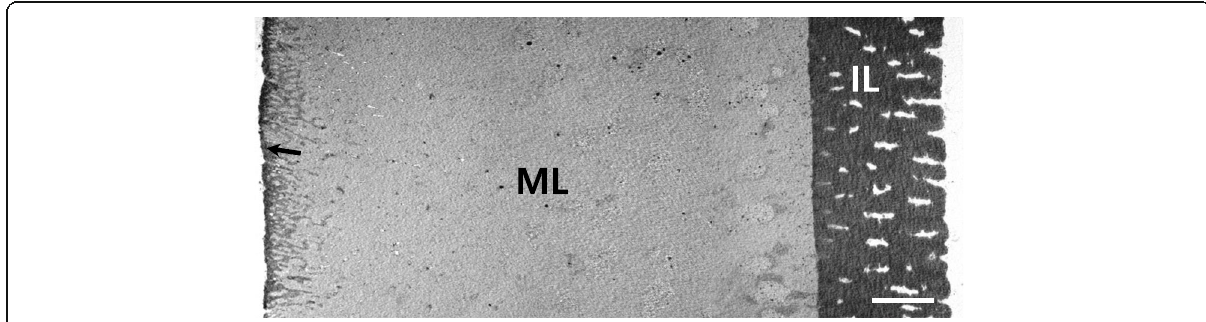
Fig. 5 Transmission electron micrograph of section of the fertilized egg envelopes from A. cirrhosus . The fertilized egg envelope consisted of three layers, an outer layer with high electron density (arrow), a middle layer with low electron density (ML) and an inner layer with grooves (IL) (Scale bar = 3 μ